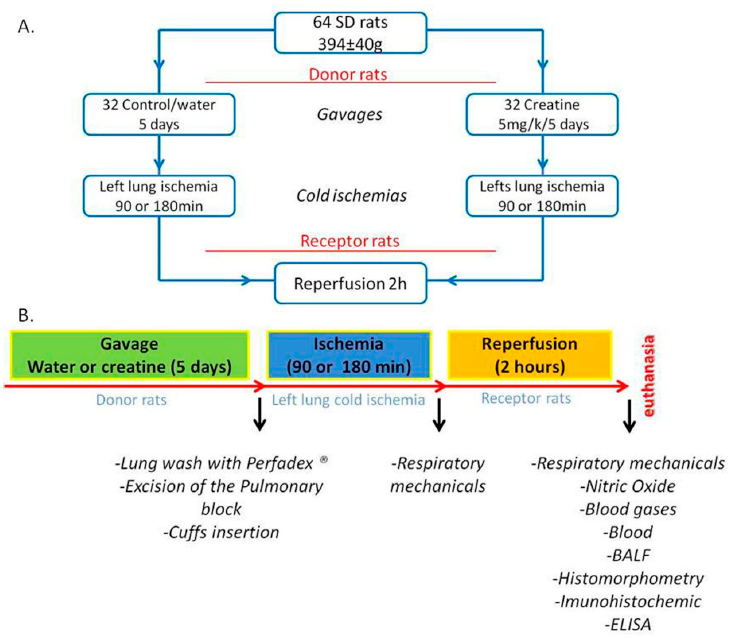
Figure 1. Study design. ( A ) groups and treatment; ( B ) methods and analysis.